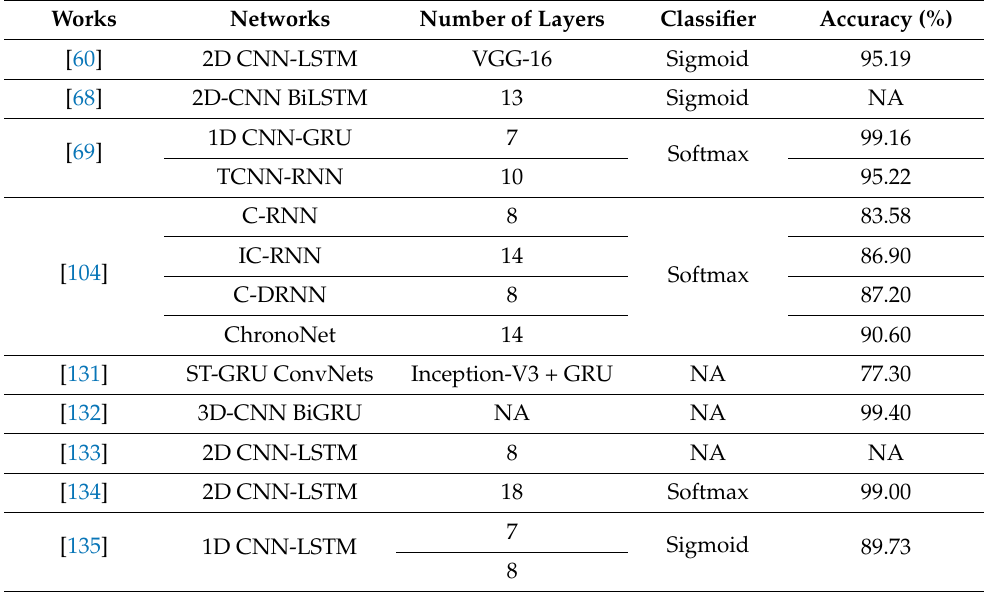
Table 6. Summary of related works done using CNN-RNNs.